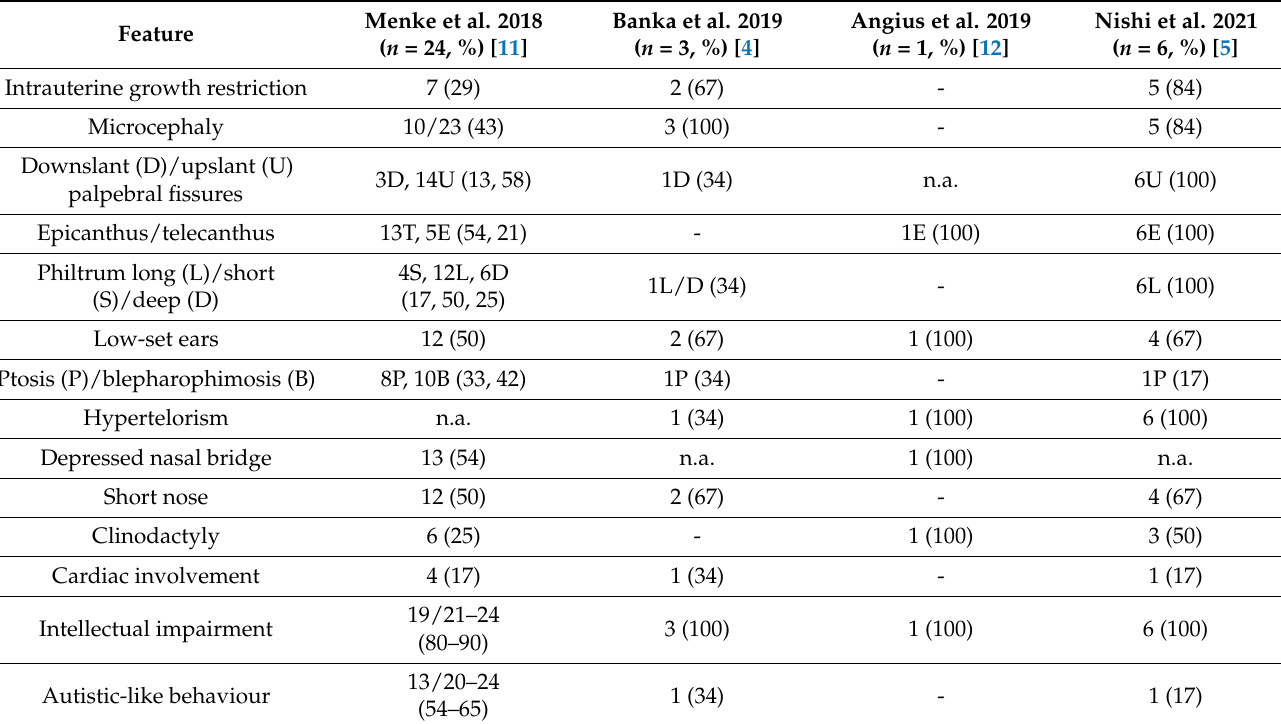
Table 2. The incidence of several typical features of